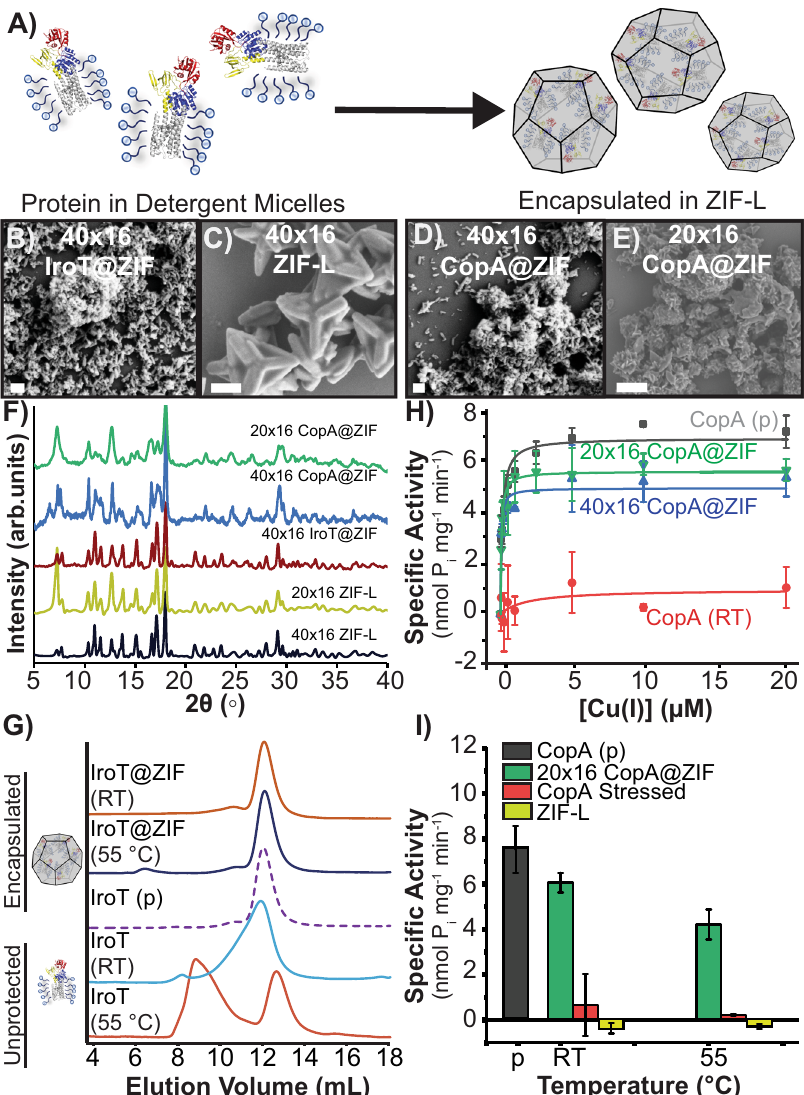
Fig. 4 IroT@ZIF and CopA@ZIF characterization. A Biomolecular nucleation of detergent stabilized CopA and IroT in ZIF. SEM micrographs of ( B ) 40× 16 IroT@ZIF (Scale bar = 200 nm) and ( C ) 40× 16 ZIF-L (Scale bar = 1 μ m). SEM micrographs of ( D ) 40× 16 CopA@ZIF (Scale bar = 200 nm) and ( E ) 20× 16 CopA@ZIF (Scale bar = 1 μ m). F PXRD of 40× 16 IroT@ZIF (brown), 40× 16 CopA@ZIF (blue), 20× 16 CopA@ZIF (green), 20× 16 ZIF-L (yellow), and 40× 16 ZIF-L (black). Y -axis expressed as arbitrary units (arb. units). G SEC traces of heated IroT@ZIF bio-composites against native and nonencapsulated IroT. IroT@ZIF RT (orange), Lp@ZIF 55°C (blue), IroT pristine (purple-dashed line), IroT RT (blue), and IroT 55°C (dark-orange). H ATPase activity analysis of CopA pristine (gray) against stressed and exfoliated 40 × 16 CopA@ZIF (blue), 20× 16 CopA@ZIF (green), with unencapsulated control (red line) (Error bars = standard deviation ( n = 3)). I Comparison of maximal speci fi c activity in CopA samples and controls (Error bars = standard deviation ( n = 3)). CopA pristine (gray), 20× 16 CopA@ZIF (green), unencapsulated CopA (red), and ZIF-L pristine non-stressed and refrigerated IroT controls (12.0 mL) as shown in Fig. 4G. Incredibly, even exposure to 80 °C (5 min) produced minimal aggregation (Supplementary Fig. 15A).